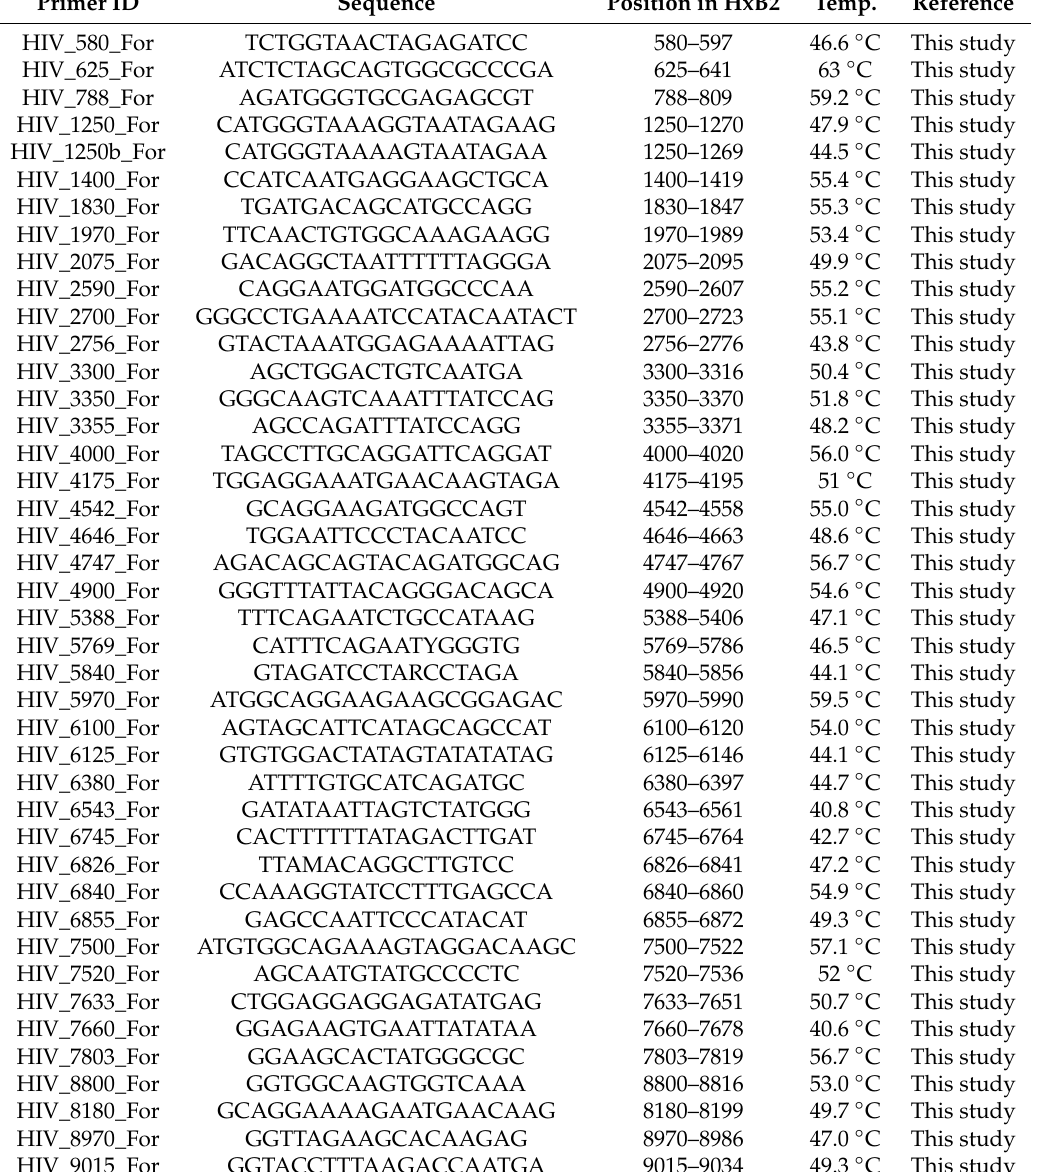
Table 2. Forward sequencing